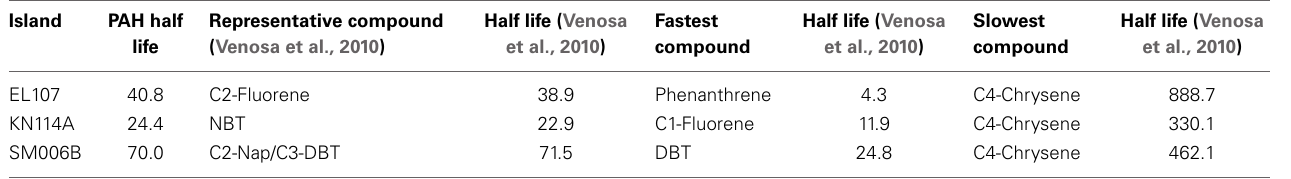
Table 5 | Comparison of biodegradation rates for nutrient-amended experiments. Island